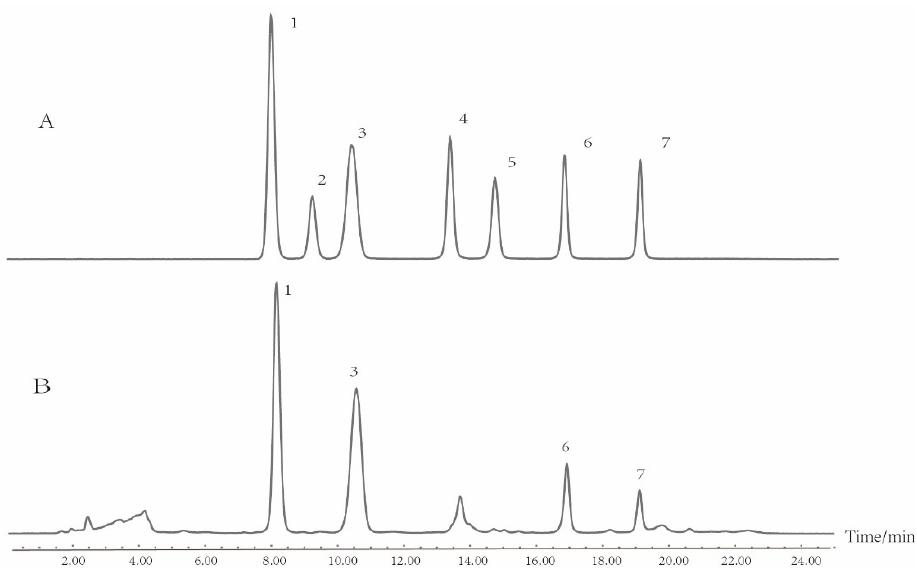
Figure 2. HPLC-ELSD chromatogram of mono-oligosaccharides in T. kirilowii . ( A ) Mixed reference; ( B ) leaves of sample S1 (Wanlou 7); (1) fructose; (2) mannose; (3) glucose; (4) sucrose; (5) maltose; (6) raffinose; (7) stachyose.